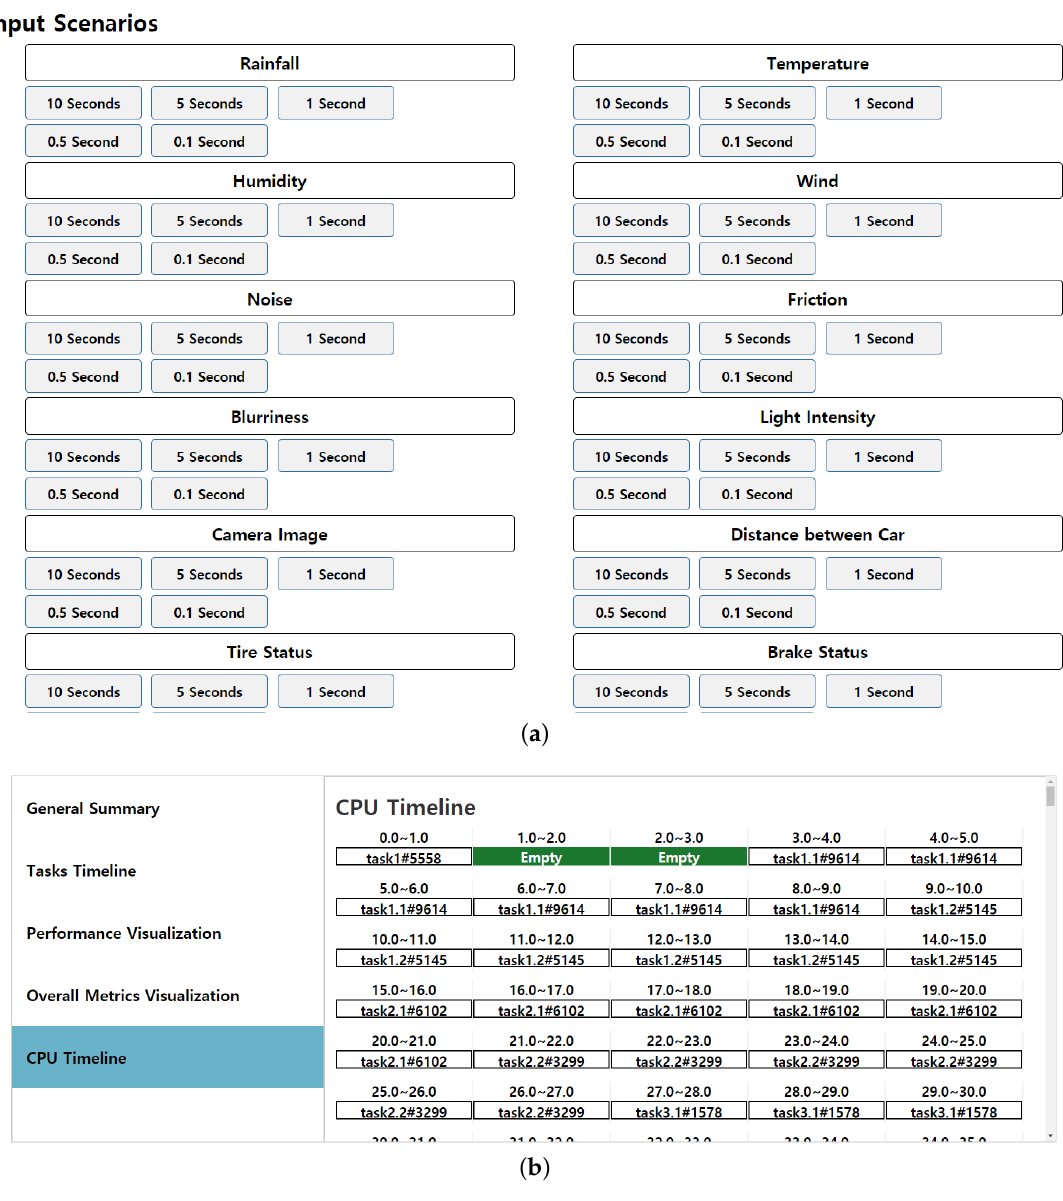
Figure 6. Interface for ( a ) task simulation scenarios and ( b ) scheduler